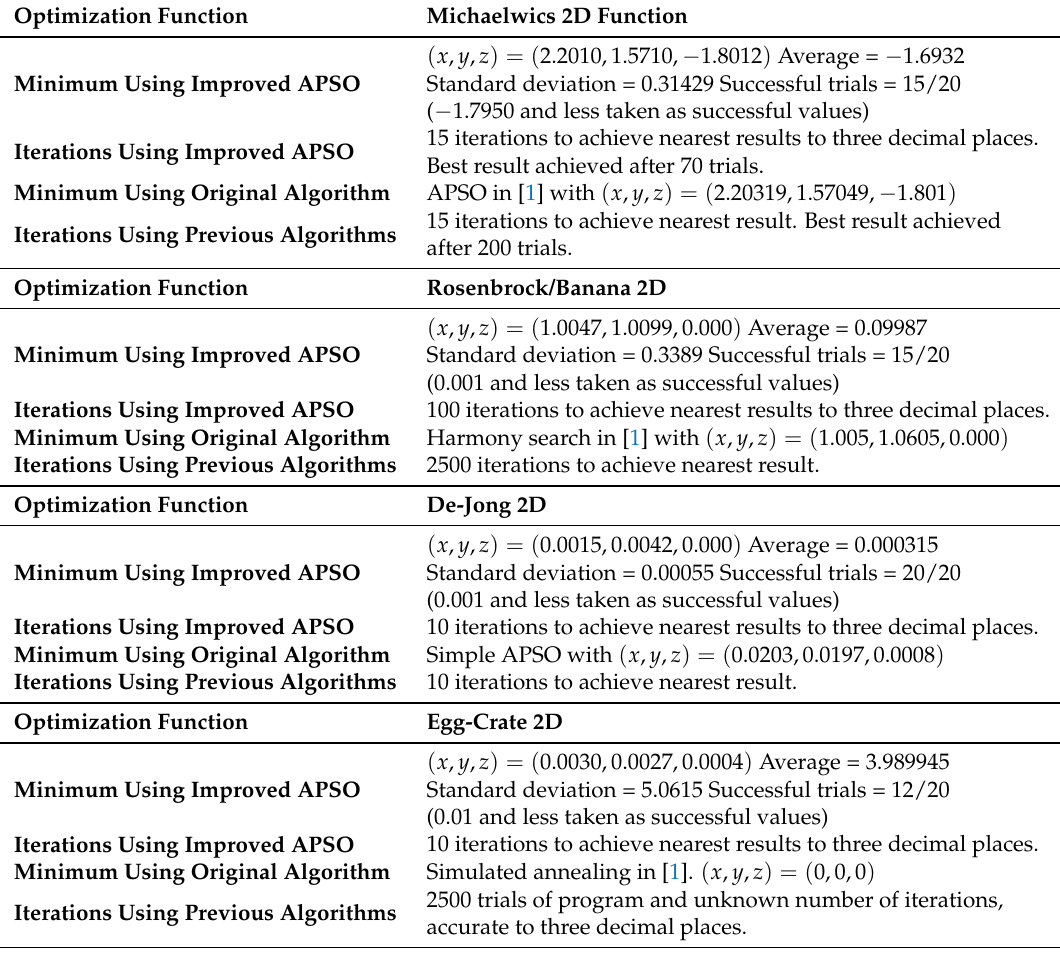
Table 17. Performance of the proposed improved APSO compared with available references. Optimization